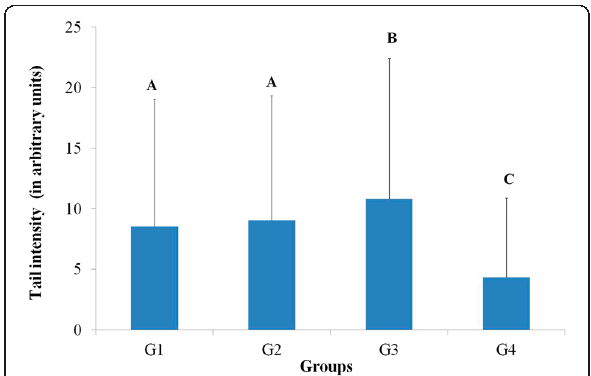
Figure 1 DNA damage analysis (tail intensity) in peripheral blood through comet assay. G1: mice inoculated with the fungus and under dietary restriction, G2: mice not inoculated with the fungus and under dietary restriction, G3: mice inoculated with the fungus and on normal diet and G4: mice not inoculated with the fungus and on normal diet. Results are represented as mean and standard deviation. Same capital letter represents no significant difference by the gamma distribution test at a level of 5% (G1 = G2; G3 > G1, G2, G4; G4 < G1, G2,